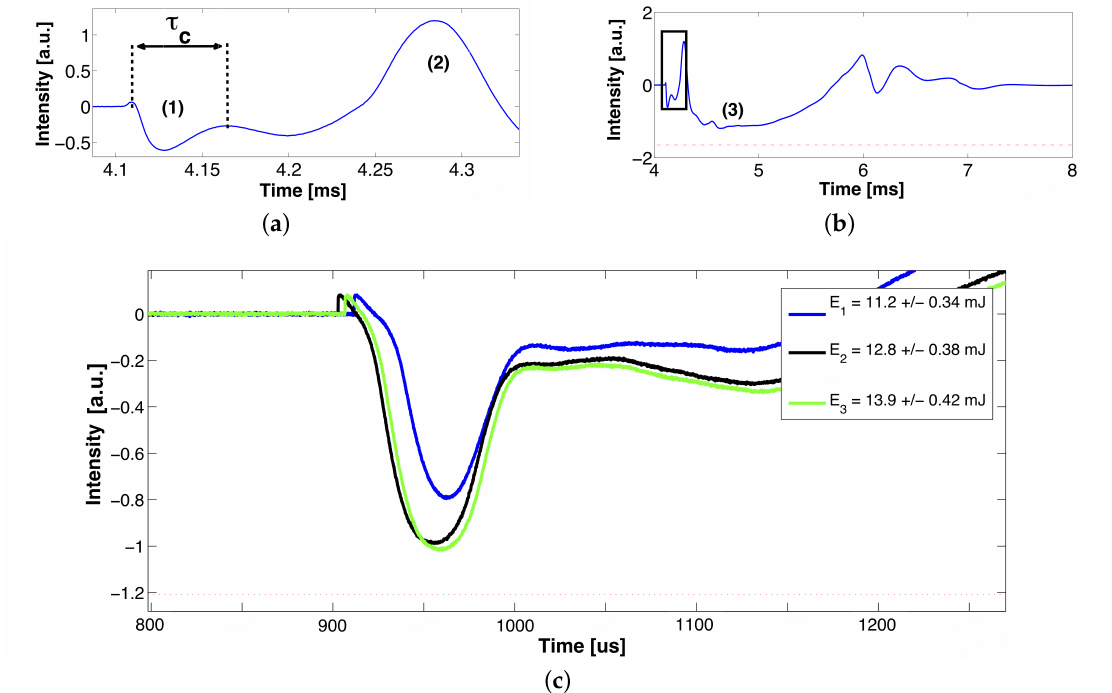
Figure 7. Typical STM signal generated in the AC of an ex vivo pig eye. ( a ) Growth and first collapse of the cavitation bubble τ c , ( b ) region (3) corresponds to the contribution of multiple microbubbles after the first collapse, and ( c ) shows a zoom into ( b )’s inset, which corresponds to the segment of the STM that contains the collapse time value of interest for three close per-pulse energy levels. The signals were triggered to match at the bubble